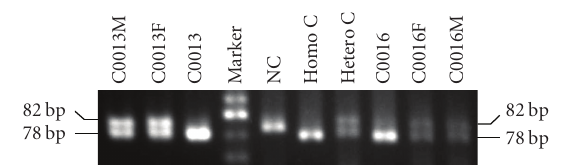
Figure 3: PCR-gel electrophoresis analysis of mutation 851del4 in the gene SLC25A13 of the two families with citrin-deficient patients C0013 and C0016. NC, Homo C and Hetero C in this figure are abbreviations of Normal Control, Homozygous Control and Heterozygous Control, respectively. F and M in the two families represent Father and Mother, respectively. The 78 bp PCR products in both patients are 4bp shorter than the normal size 82bp, suggesting that the 2 patients are both 851del4 homozygotes, and their parents all carriers of the same